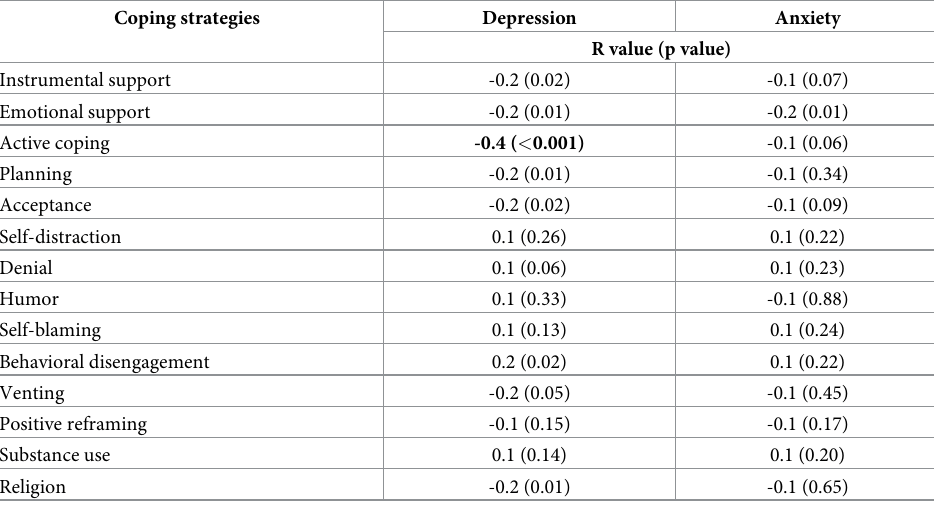
Pearson correlation test was